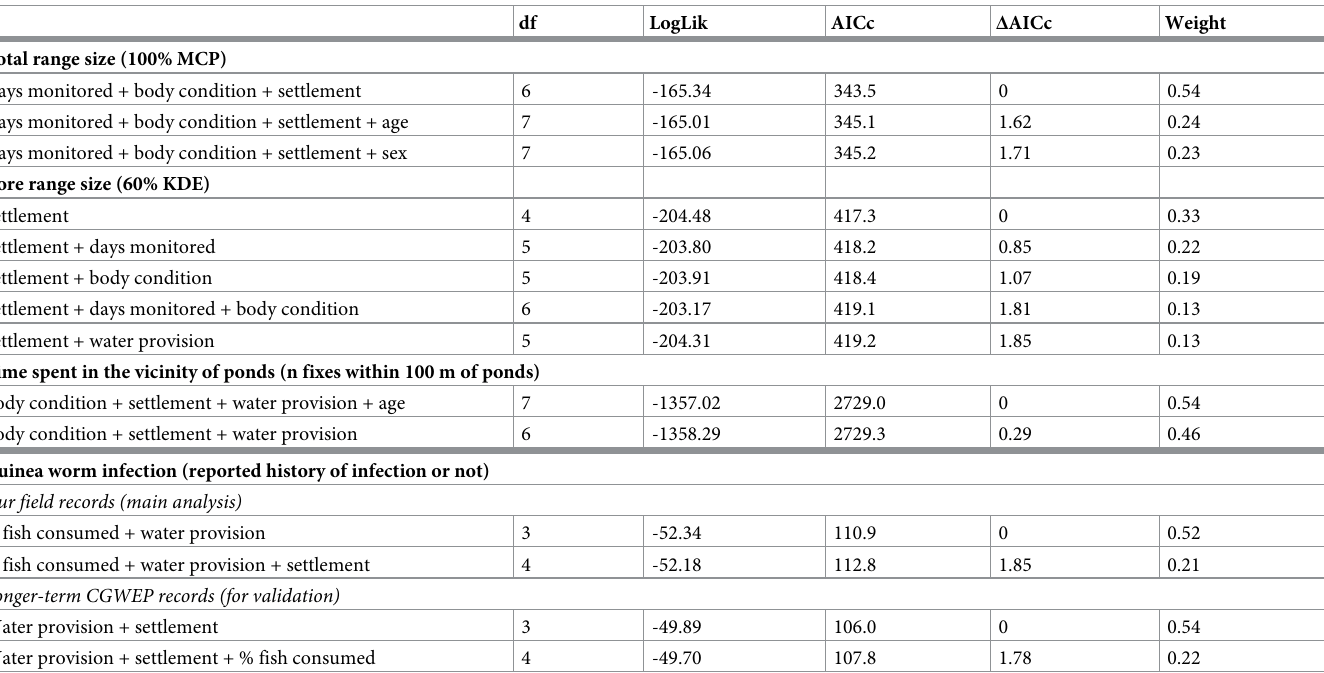
Table 3. Summaries of analyses of variation in dog range sizes, time spent by dogs in the vicinity of ponds and history of Guinea worm infection in dogs in rural Chad. Core range is the 60% kernel density estimate and total range is the 100% minimum convex polygon. History of Guinea worm infection is from our field survey rec- ords and records held by the Chad Guinea Worm Eradication Program. Model outcomes are shown as the top model sets ( Δ AICc < 2 from the top model) for all analyses.